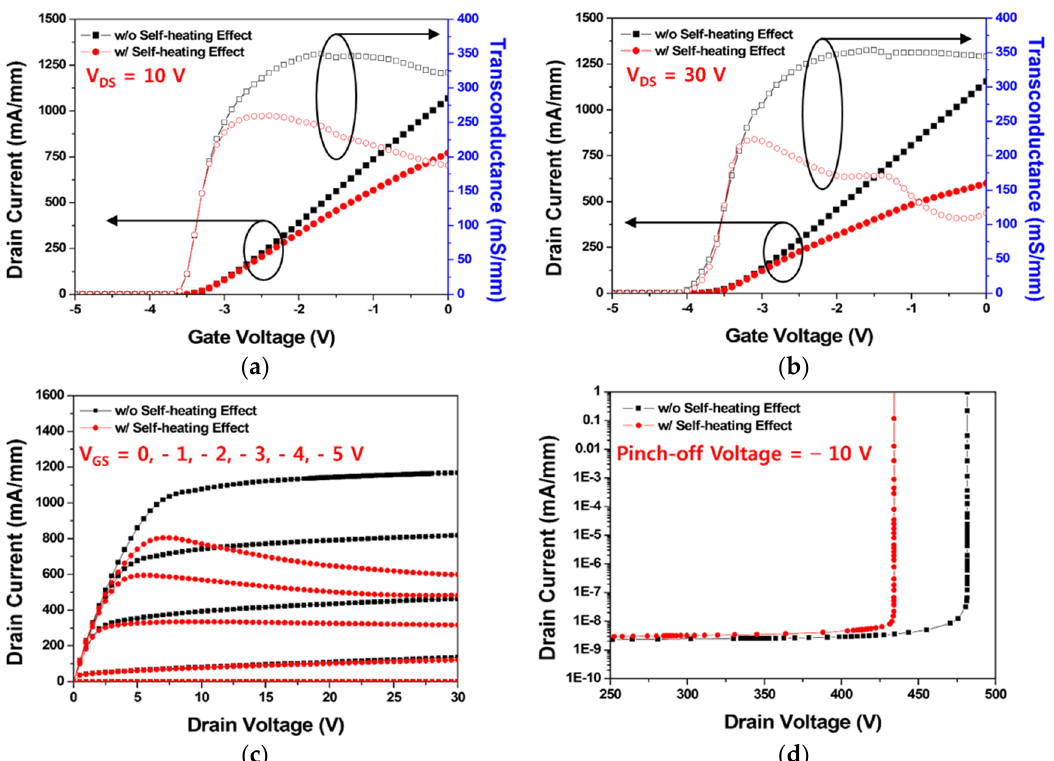
Figure 6. Direct current (DC) characteristics of the BGS HEMT structure with and without the SHE: I–V transfer characteristics at ( a ) V DS = 10 V and ( b ) V DS = 30 V; ( c ) saturation current when gate voltages were −5, −4, −3, −2, −1, and 0 V; and ( d ) breakdown characteristics at a pinch-off of V GS = −10 V.